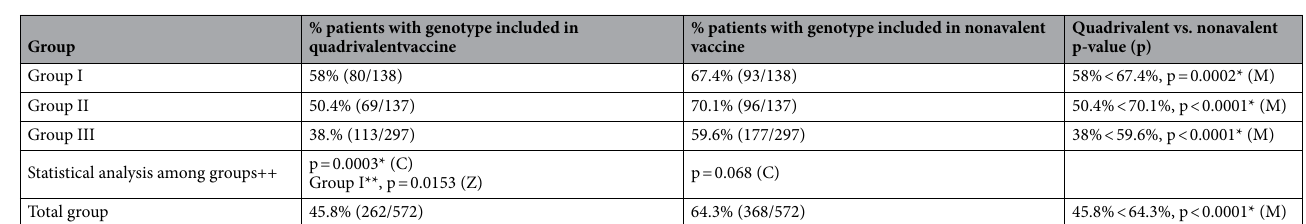
Table 3. Percentages of patients with genotype included in quadrivalent and nonavalent vaccine. *Significant test, **Most frequent, ***Less frequent; C = multiple comparison χ 2 test; Z = Z-test; M = McNemar exact test; ++ = the statistical analysis was performed for column; p =